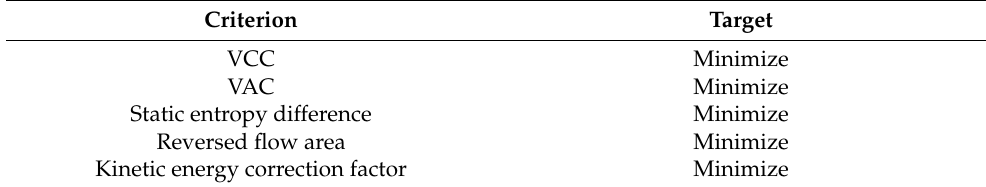
Table 4. Optimization criteria and their